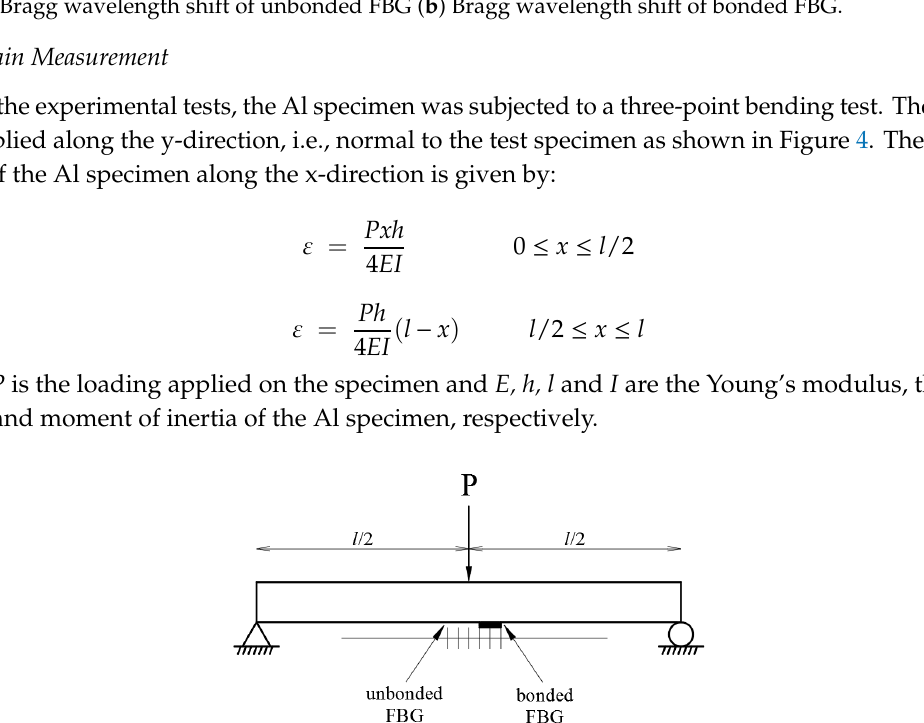
Figure 3. Bragg wavelength shift of unbonded and bonded FBG due to the temperature change. ( a ) Bragg wavelength shift of unbonded FBG ( b ) Bragg wavelength shift of bonded FBG.